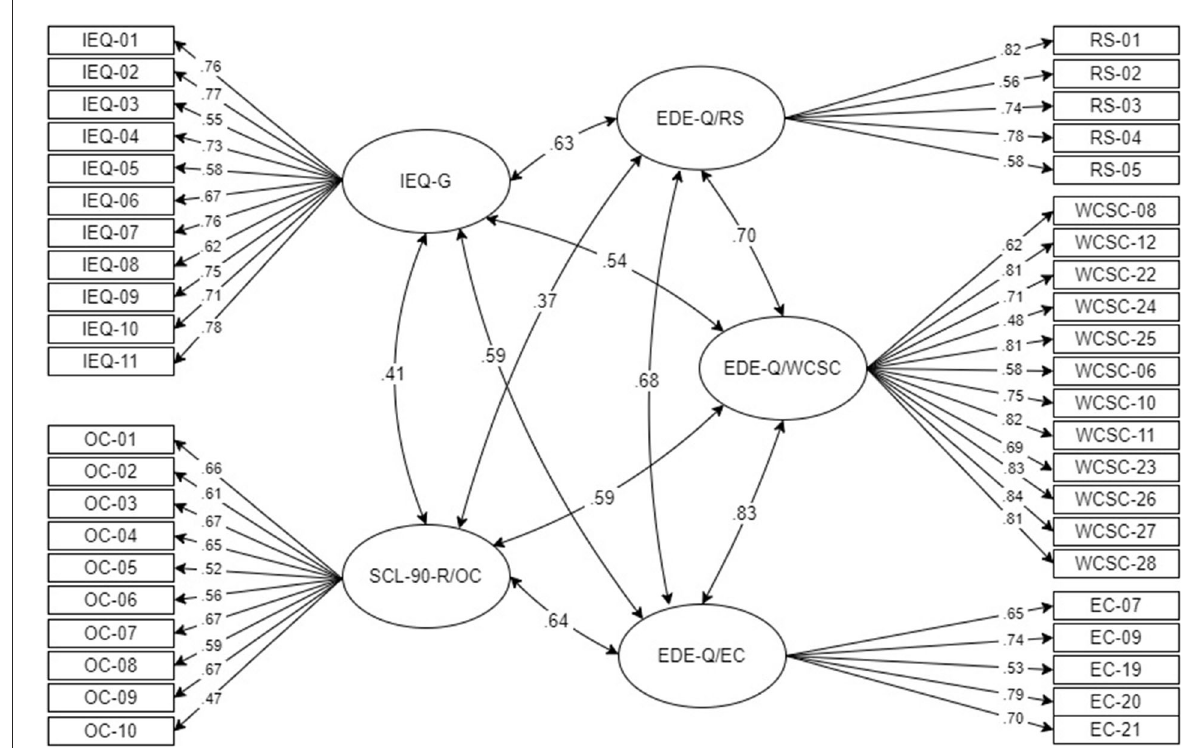
FIGURE2 Depiction of SEM with standardized loadings and latent correlation